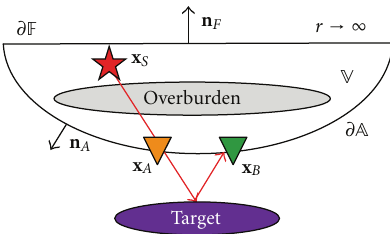
Figure 13: Configuration for controlled-source interferometry by multidimensional deconvolution of perturbed fields; integration volume V is enclosed by the free surface ∂ F and receiver array ∂ A ; x S denotes a source location; x A and x B denote receiver locations at ∂ A and n A is the unit normal vector of the receiver array; n F is the unit normal vector of the free surface; heterogeneities between sources and receivers are referred to as “overburden,” whereas heterogeneities below the receivers are referred to as